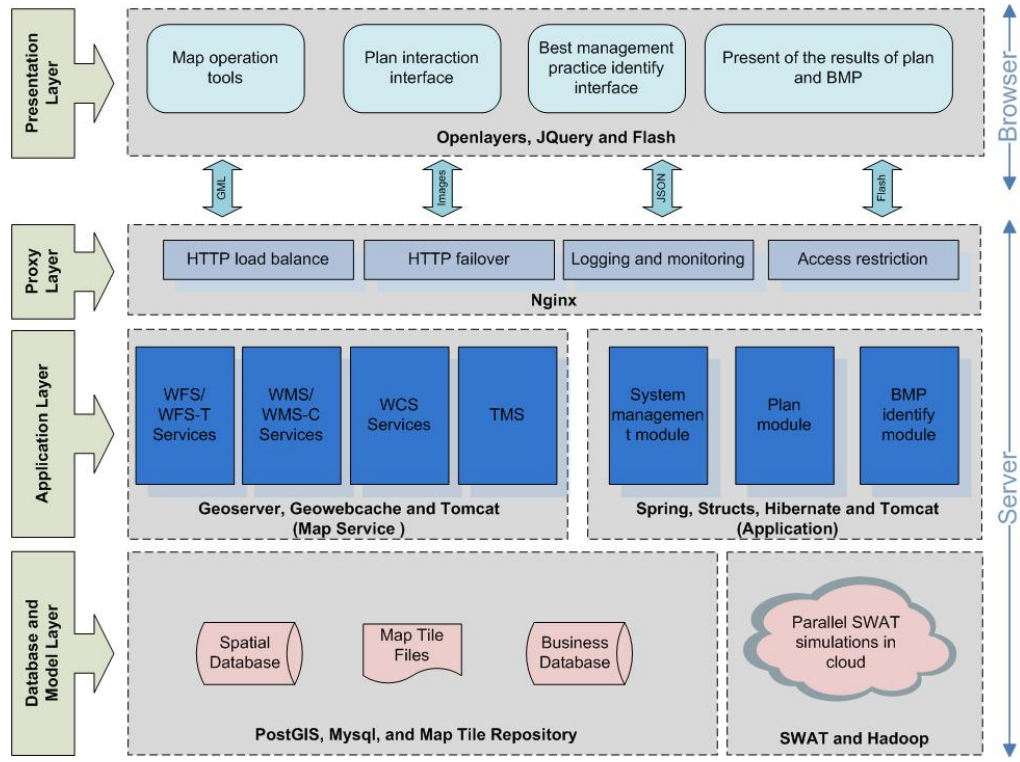
Figure 1. The system architecture of decision support system for watershed management (DSS-WMRJ). WFS/WFS-T, Web Feature Service/Web Feature Service-Transaction; WMS, Web Map Service; WCS, Web Coverage